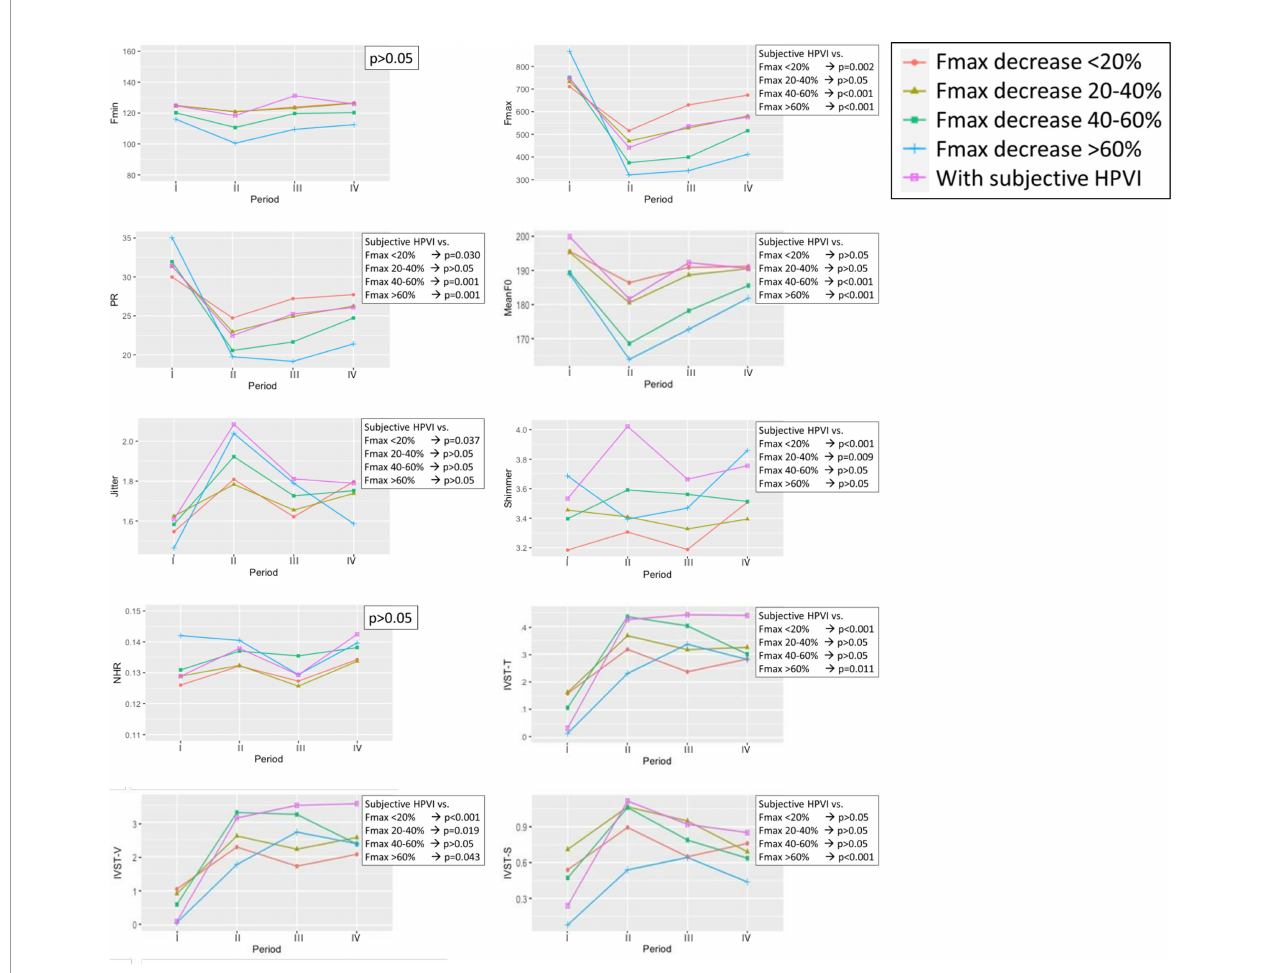
FIGURE 2 | Voice parameter changes in patients with different severity of objective high-pitched voice impairment (HPVI) and patients with subjective HPVI in each follow-up period. Red line = Fmax decrease <20%; Olive line = Fmax decrease 20-40%; Green line = Fmax decrease 40-60%; Blue line = Fmax decrease > 60%; Purple line = Patients with subjective HPVI. period-I = Preoperative period (within 2 months before surgery); period-II = Immediate postoperative period (median duration of 3 days; range of 1-7 days); period-III = Short-term postoperative period (median duration of 12 days; range of 7-30 days); period-IV = Long-term postoperative period (median duration of 40 days, range of 30-90 days). A p value less than 0.05 was considered statistically signi fi